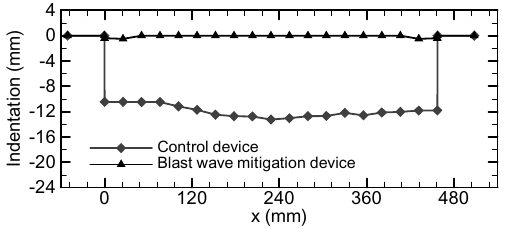
Fig. 9. Honeycomb indentations with the control device and the blast wave mitigation